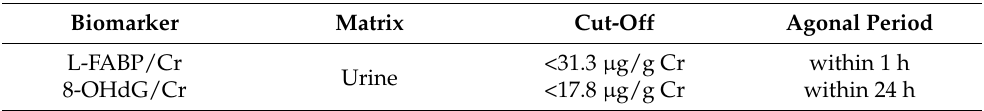
Table 1. Proposed cut-offs for the urinary